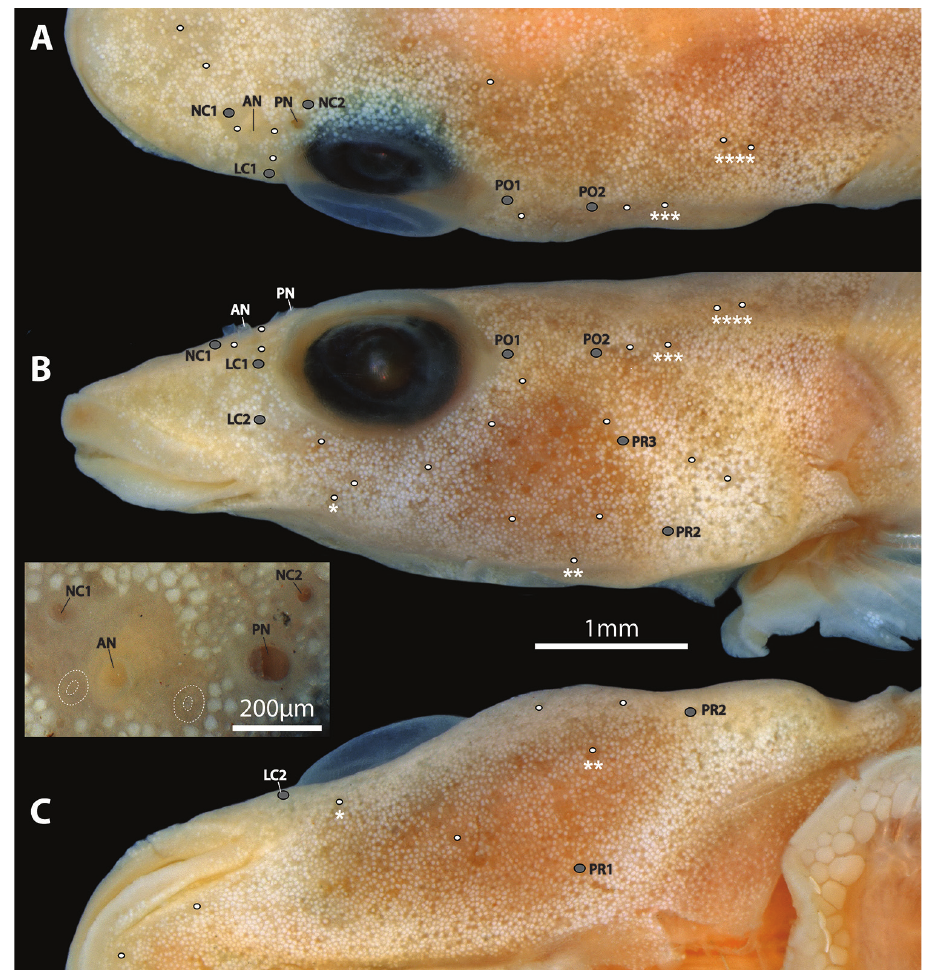
Figure 3. Head of Flexor incus (NMNZ P.025315, paratype, 19.4 mm SL) in dorsal ( A ), lateral ( B ), and ven- tral ( C ) view highlighting position of cephalic lateral line canal pores (grey circles) and superficial neuromasts (white circles) on the left side of the head. Close-up view of nostrils shown in inset image between B and C Superficial neuromasts highlighted by white dotted line in inset image. Single scale bar shared between A–C . Skin on ventral surface of head damaged on right side of specimen. Superficial neuromasts on surface of body not highlighted. Asterisks (*, **, ***, ****) label individual superficial neuromasts that are visible in different views. Abbreviations: AN, anterior nostril; LC1-2, lachrymal canal pores 1–2; NC1–2, nasal canal pores 1–2; PN, posterior nostril; PO1–2, postorbital canal pores 1–2; PR1–3, preopercular canal pores